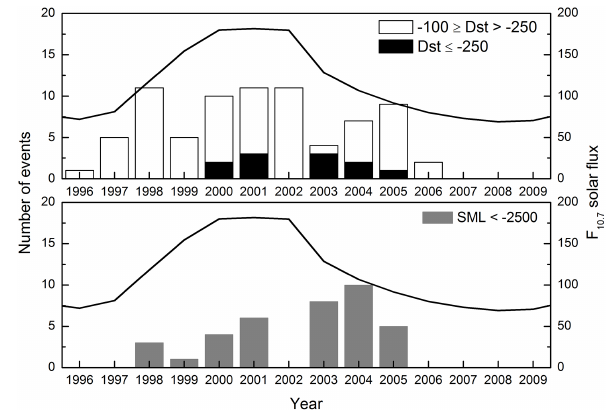
Figure 1. In the upper panel, the open and black histograms show the intense ( − 100nT ≥ Dst > − 250nT) and super (Dst ≤− 250nT) geomagnetic storms annual occurrence rates for the period 1996 to 2009, respectively. The scale for both is on the left. In the bottom panel, the supersubstorm (SML ≤ − 2500nT) annual occurrence rate is given in histogram format. The scale is on the left. The solid lines in both the panels show the F 10 . 7 solar flux levels. The scale is on the